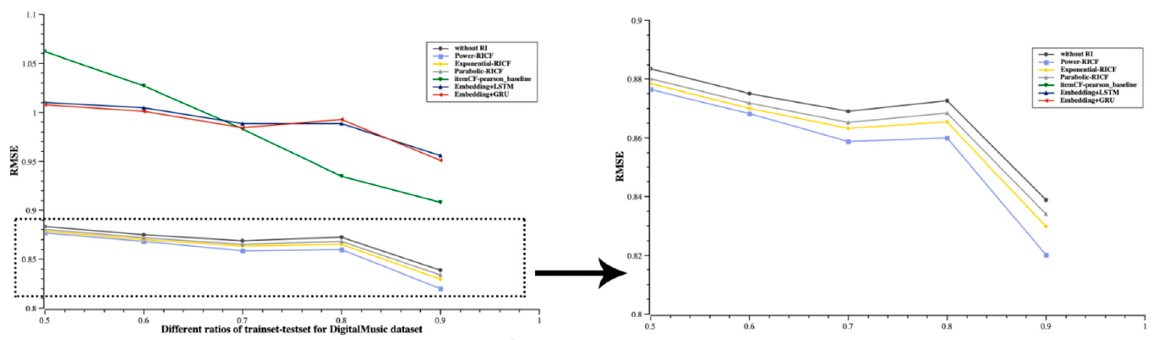
Figure 15. RMSE of seven algorithms on the DigitalMusic dataset.